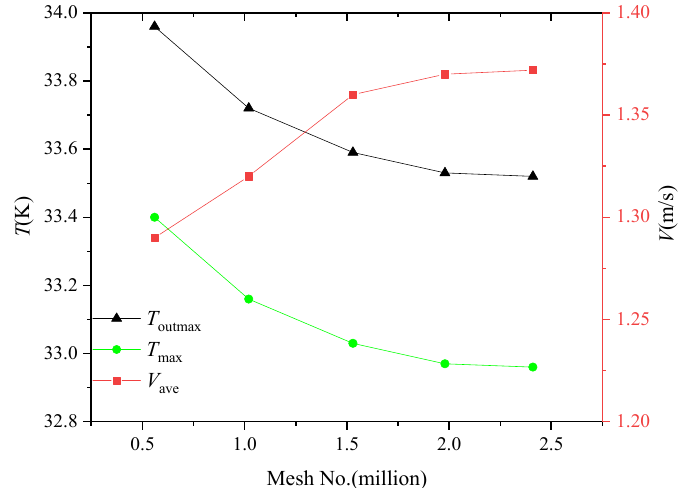
Figure 4. Grid independence validation of CHM.